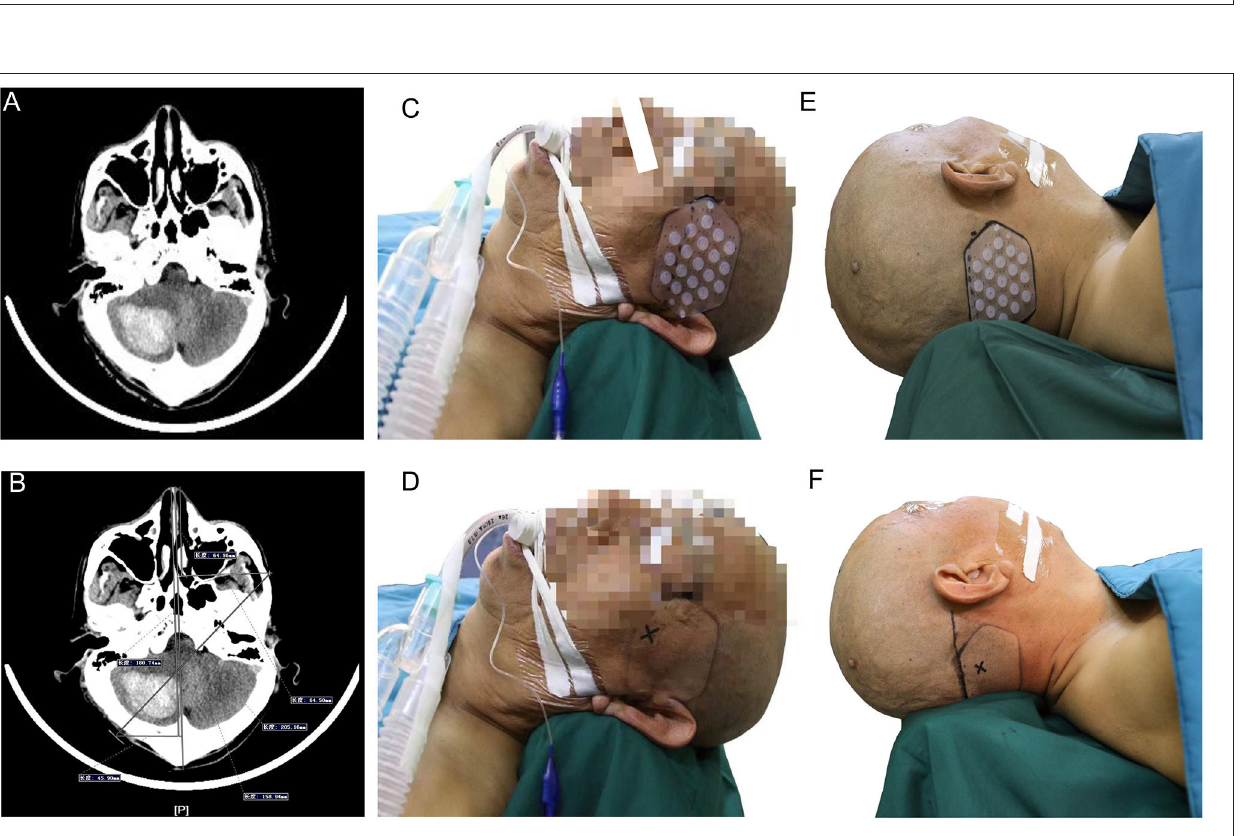
FIGURE 8 | Right cerebellar hemorrhage shown in (A) . A vertical distance of 45.90mm (puncture point) from the centerline and a parallel distance of 64.96mm (reference point) along the centerline are shown in (B) to locate the location sticker in (C–F) .